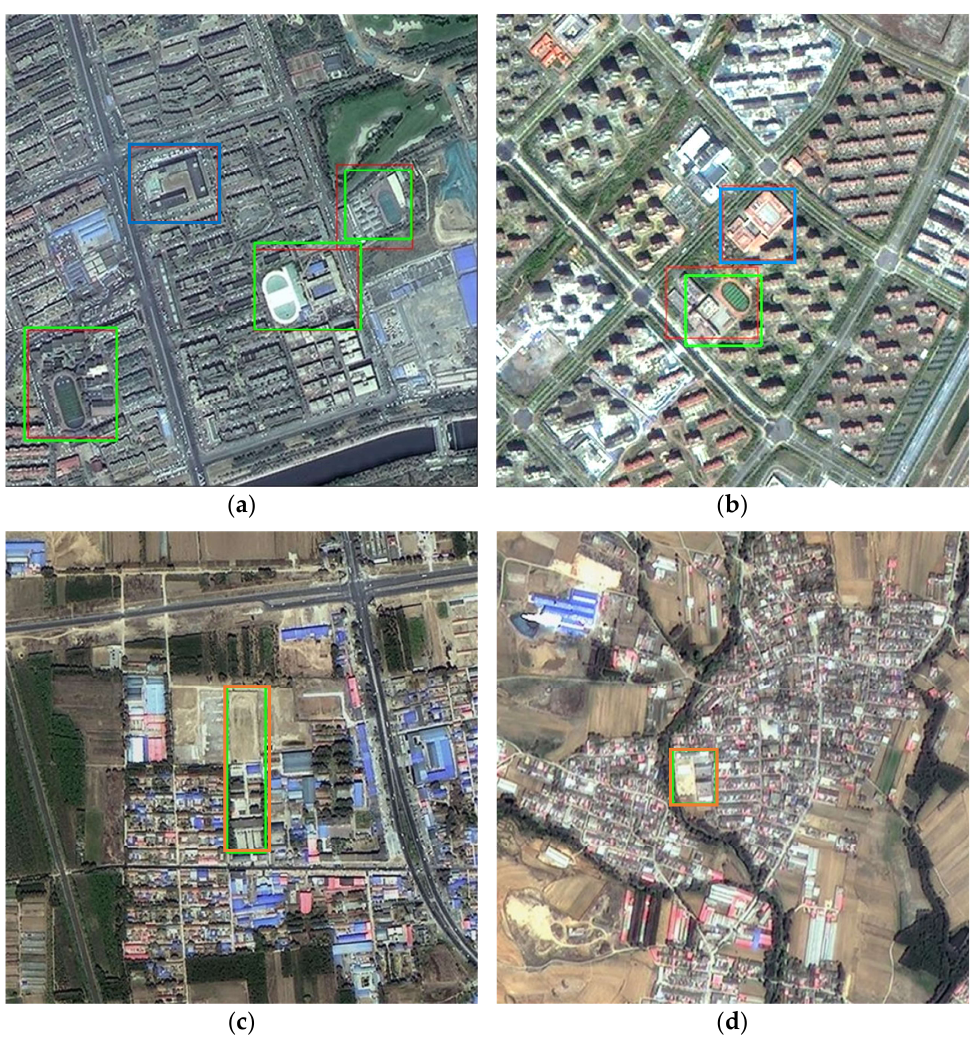
Figure 13. Some detection results of proposed methods on the test set. The false positives and false negatives are plotted in blue and orange, respectively: ( a , b ) false positives; ( c ) missed objects with unclear features; ( d ) missed small objects.